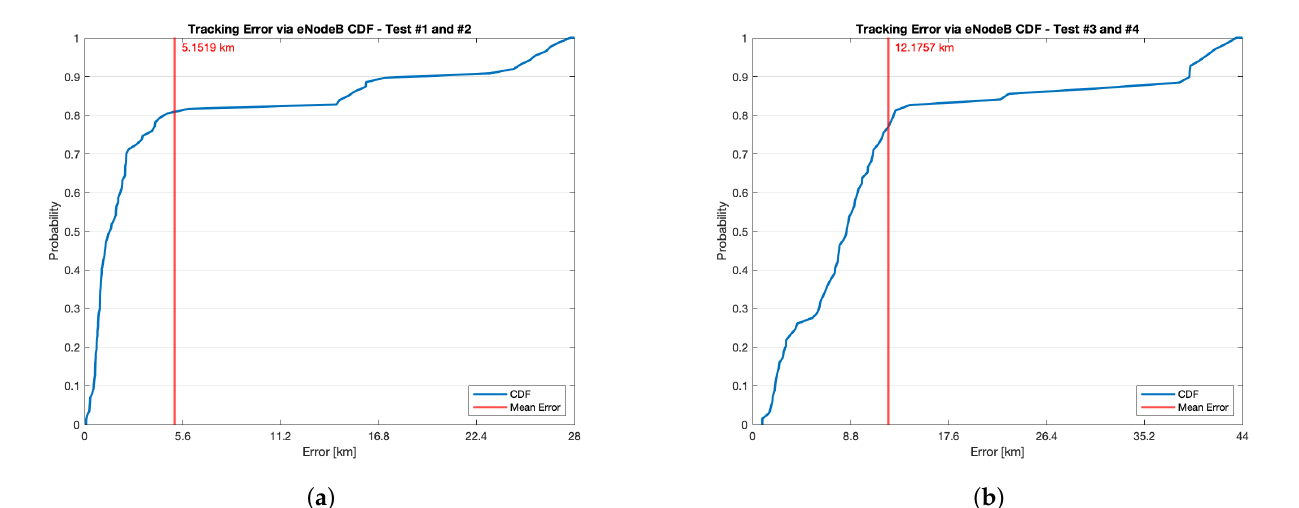
Figure 10. Tracking accuracy test results concerning tracking error CDF and mean value for ( a ) the itinerary of Figure 6a and for ( b ) the itinerary of Figure